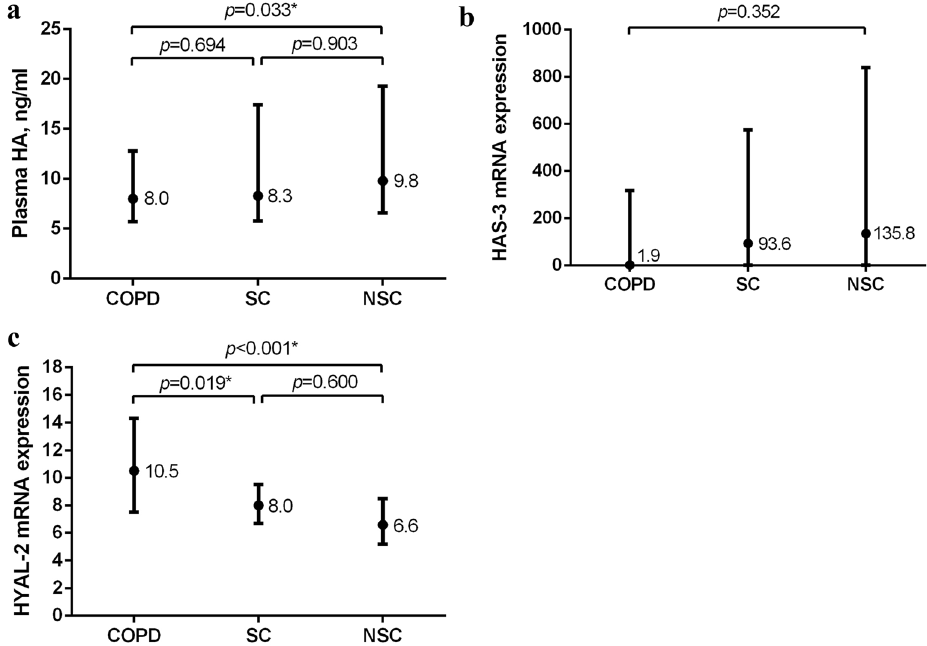
Figure 1. ( A ) Plasma hyaluronic acid (HA) in patients with COPD (n = 192), smoking controls (SC, n = 84) and non-smoking controls (NSC, n = 107). ( B ) mRNA expression of HAS-3 and; ( C ) HYAL-2 in patients with COPD (n = 143), SC (n = 21) and NSC (n = 20). Median and interquartile ranges are presented. *Significant post-hoc pairwise comparison. Figures were created using GraphPad Prism 8.3.5, https:// www. graph pad. com/ scien tific- softw are/